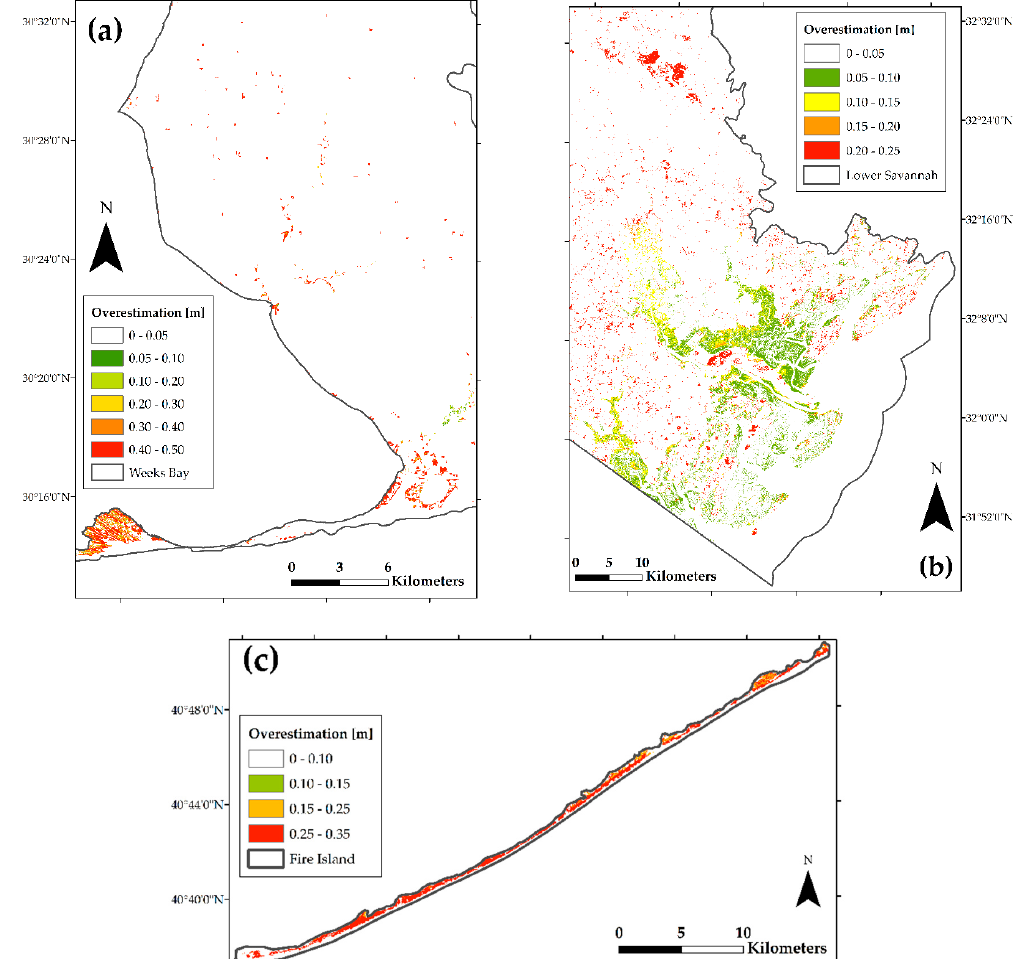
Figure 4. Overestimation of emergent herbaceous wetland elevation in ( a ) Weeks Bay, Alabama; ( b ) Savannah Estuary, Georgia; and ( c ) Fire Island, New York computed with the DEM-correction tool.